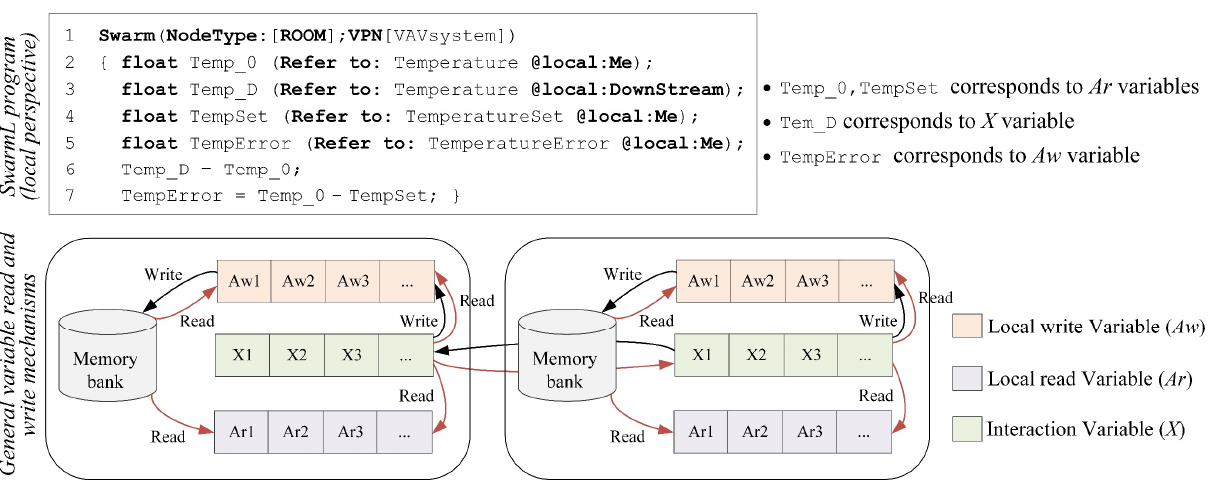
Figure 10. The correspondence between local parameters and Ar , Aw, and X variables.